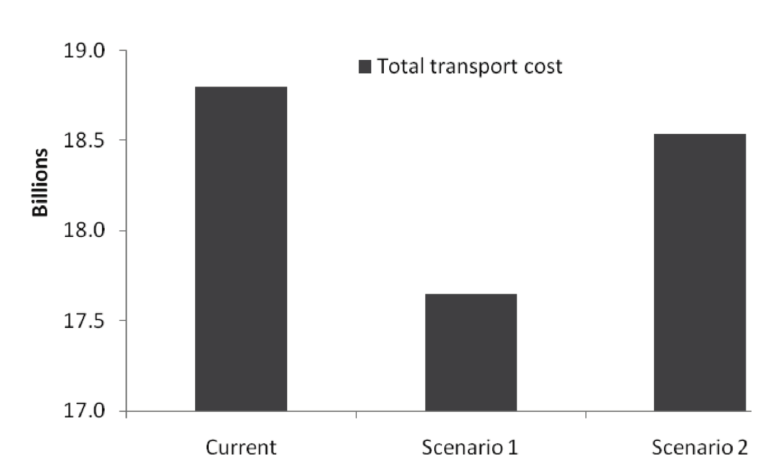
Figure 4: Comparative total transport costs: current vs. scenarios 1 and 2 (data source: FDM, 2009, and CSCM Cost Model, 2009)